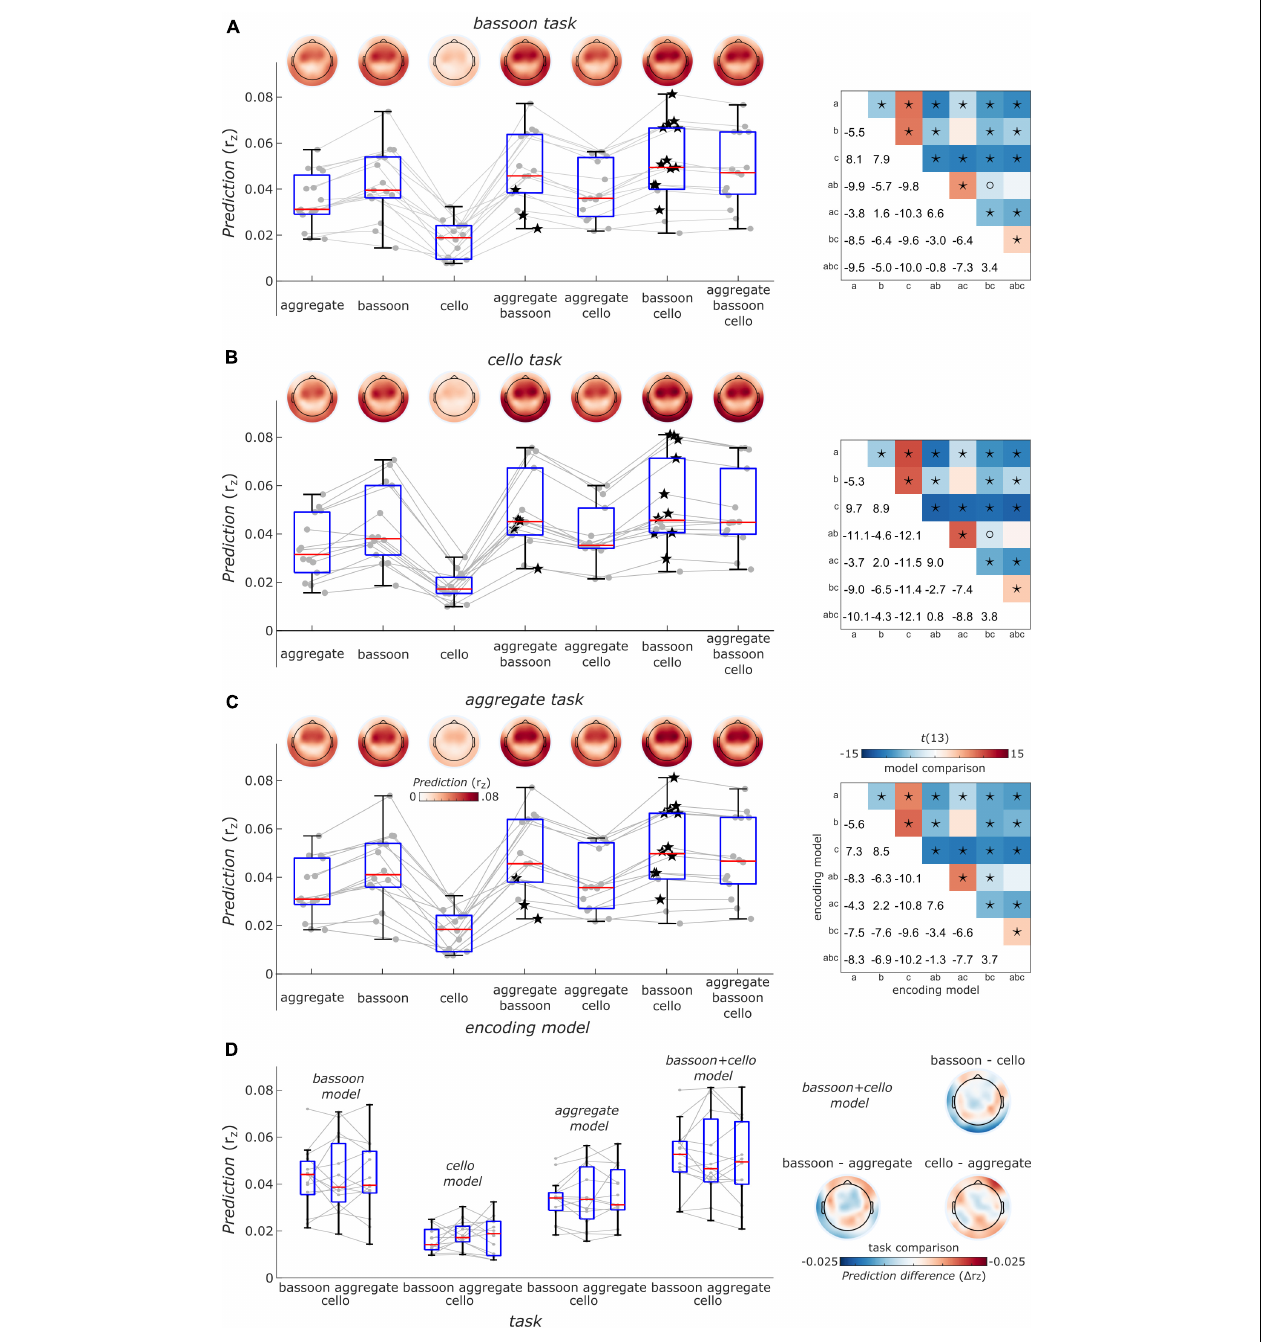
FIGURE 7 | Overview of EEG prediction performance. (A) Encoding models prediction performance for EEG data acquired during the bassoon task. Boxplots show the average model performance of different encoding models across all 63 channels. Boxes indicate the interquartile range, red lines indicate the median and whiskers reach to the most extreme data point up to 1.5 interquartile from the lower or upper quartile. Gray lines and dots denote encoding performance for individual participants. Encoding results are presented as a function of models reflecting the envelope the bassoon, cello or the aggregate or their combination with 2 or 3 predictors. Best models for individual participants are indicated by star symbols. Topographic plots show prediction performance for single channels. Right: matrices show comparisons of different models. Asterisks and open circles indicate the significant differences for model pairs at p FDR < 0.01 and p FDR < 0.05, respectively (two-sided, false-discovery-rate adjusted p -values across 21 paired comparisons). a, b, c denote the aggregate, bassoon and cello predictors to identify different encoding models. Panels (B,C) same as panel (A) but for the cello and aggregate task, respectively. (D) Right: task comparisons of encoding model prediction averaged across channels indicated as in panels (A–C) for single-predictor models and the two-predictor model with bassoon and cello envelope. Left: prediction differences for models with the bassoon and cello predictors between tasks for single channels. Neither the average prediction across channels nor the predictions for single channels were significantly different between any pair of tasks (two-sided, uncorrected).